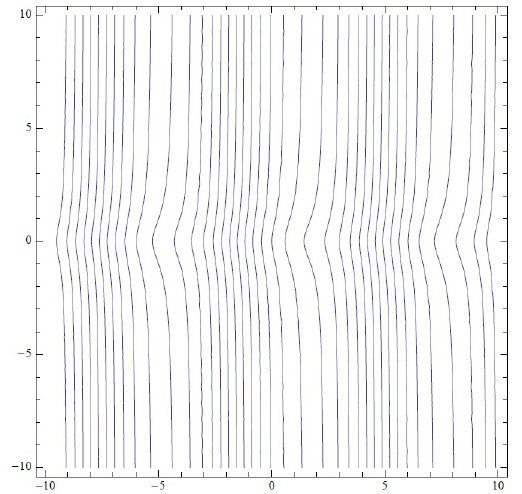
Fig. 1: Phase plane for (5.2) with the values a = 1 and H = 1